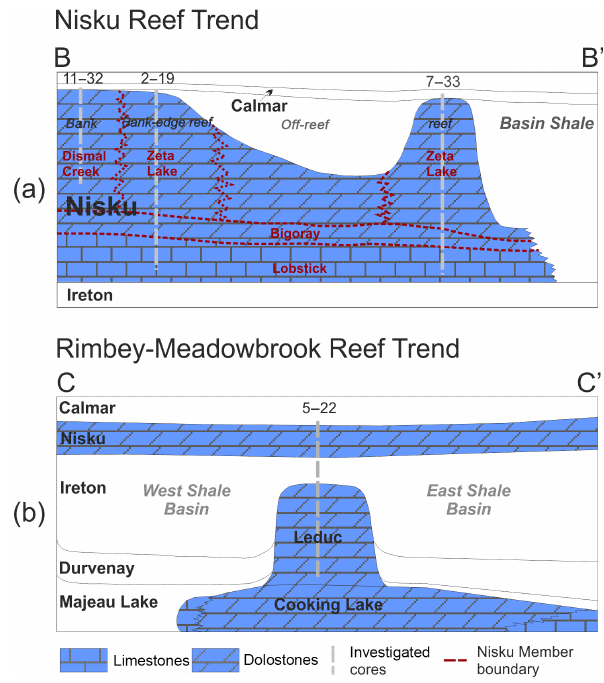
Figure 4. Schematic cross sections of the Nisku Reef Trend (a) and the Rimbey-Meadowbrook Reef Trend (b) in central Alberta based on Switzer et al. (1994). Line B–B (cid:48) and line C–C (cid:48) are shown